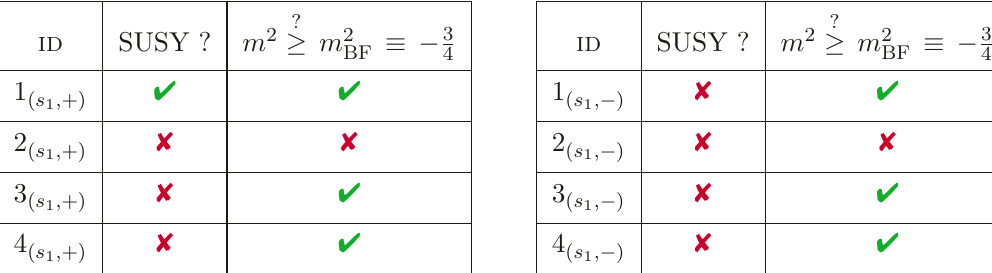
S 3 S 3 solutions within the closed-string sector. × ×